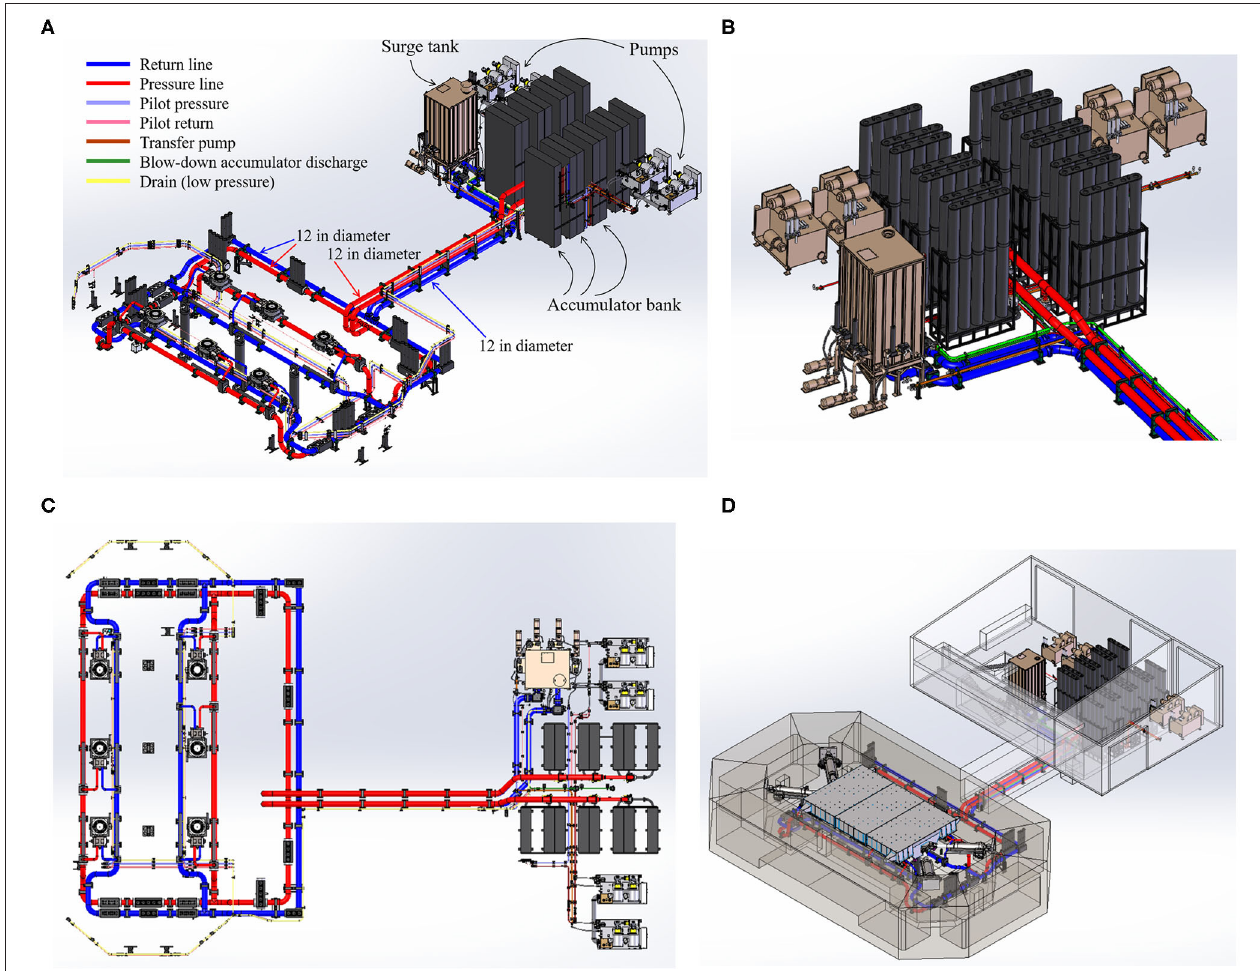
FIGURE 5 | Hydraulic power system (HPS) the LHPOST6. (A) Isometric of HPS, (B) Primary HPS components, (C) Plan view of HPS and Piping Layout, and (D) HPS in Pump House and Reaction Mass.